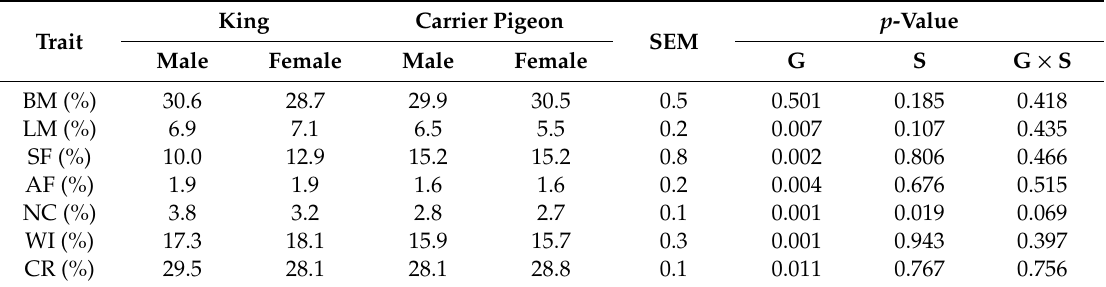
Table 2. Share (%) of carcass components in three-year-old pigeons of di ff erent genotypes. Trait